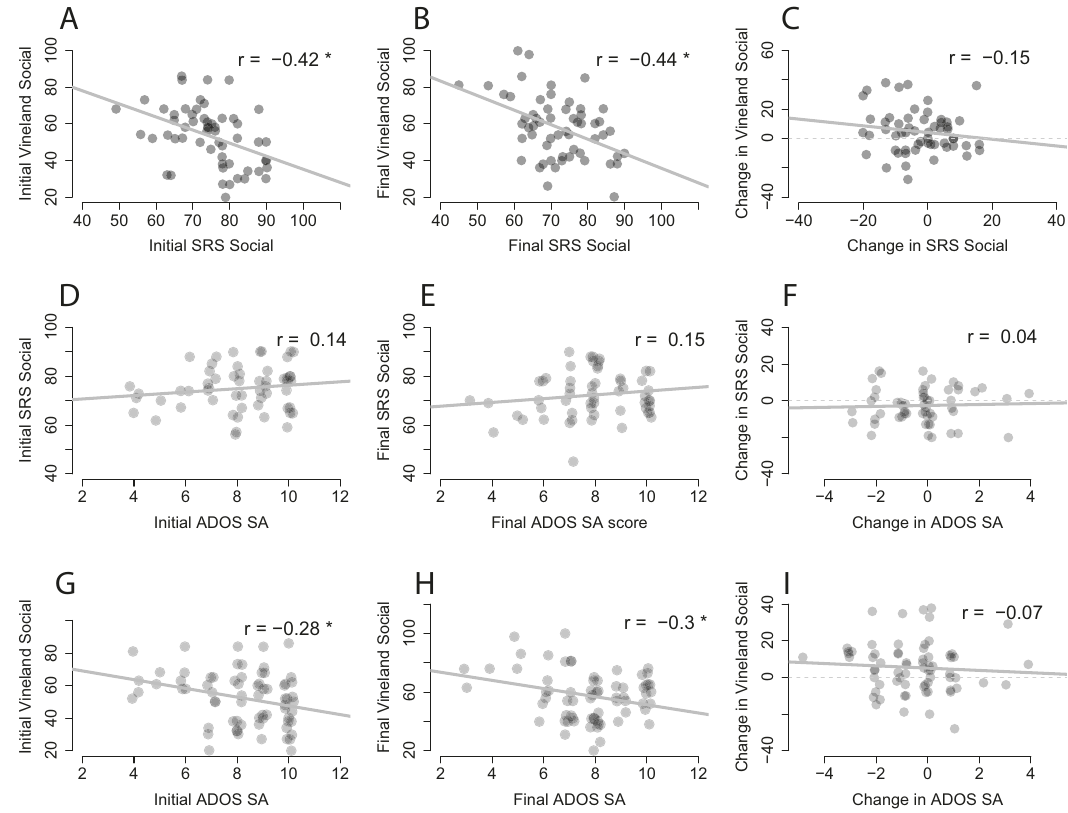
Fig. 6 Relationship across different measures of social communication skills. Scatter plots demonstrate the relationship between: A Initial Vineland socialization and SRS social scores; B Final Vineland socialization and SRS social scores; C Pre/post change in Vineland socialization and SRS social scores. D Initial SRS social and ADOS-SA CSS scores; E Final SRS social and ADOS-SA CSS scores; F Pre/post change in SRS social and ADOS-SA CSS scores. G Initial ADOS-SA CSS and Vineland socialization scores; H Final ADOS-SA CSS and Vineland socialization scores; I Pre/post change in ADOS-SA CSS and Vineland socialization scores. Asterisk: signi fi cant correlation ( p < 0.05). Gray line: linear least- squares fi